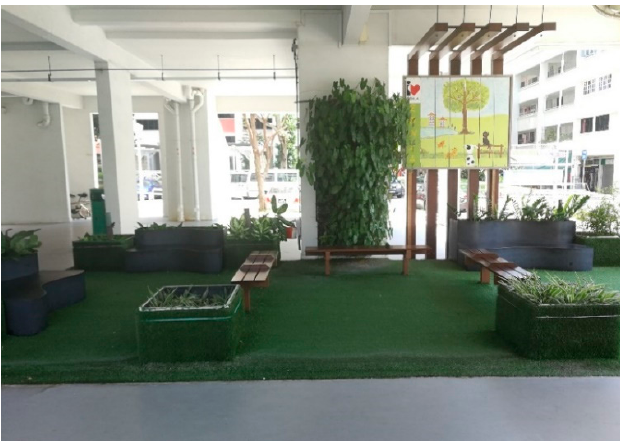
Figure 8. A seating area as a meeting garden in the void deck.